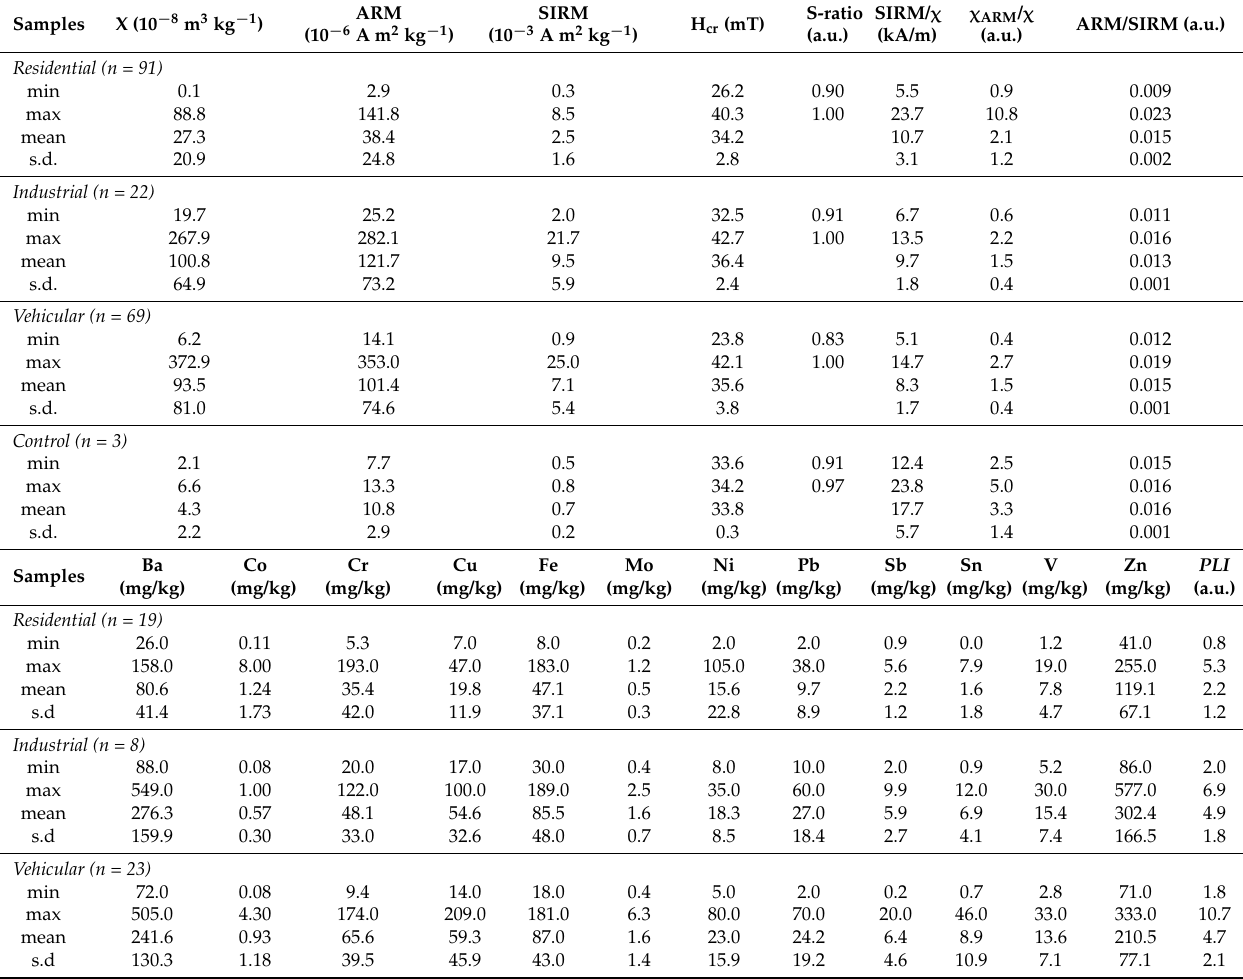
Table 1. Descriptive statistics of residential, industrial, and vehicular areas. Magnetic concentration- and mineralogy-dependent parameters, elemental concentration, and pollution index PLI